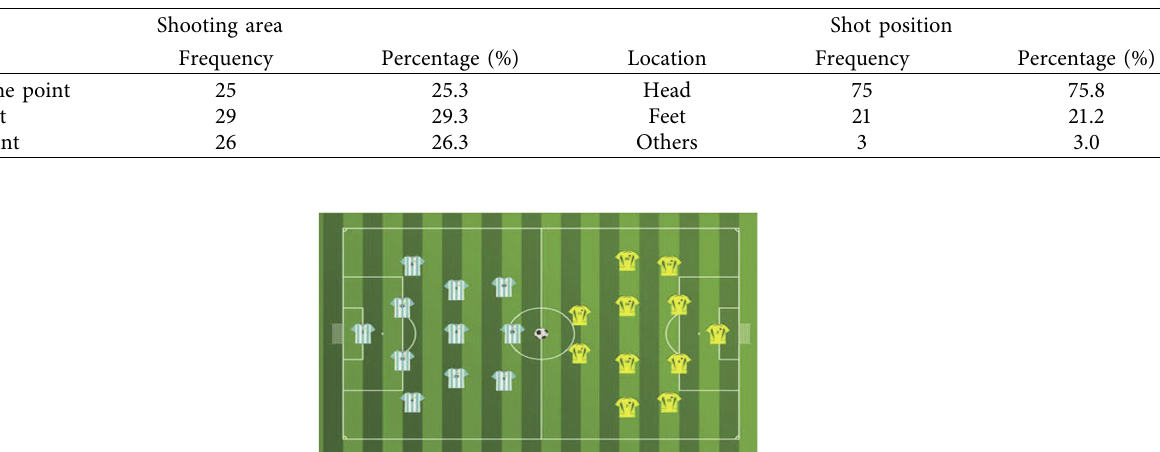
Table 2: The relationship between the final shot factor and its observed variables.